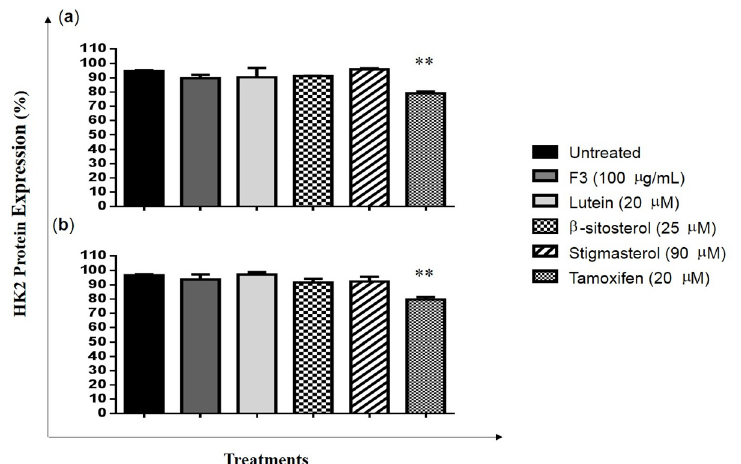
Figure 6. MDA-MB-231 cells expressed with HK2 protein. MDA-MB-231 cells were treated with IC 50 concentrations of F3, lutein, β -sitosterol, and stigmasterol for 8 ( a ) and 24 h ( b ), and HK2 protein expression was measured using flow cytometry. Data are presented as the mean ± SD ( n = 3). ** p < 0.01 .